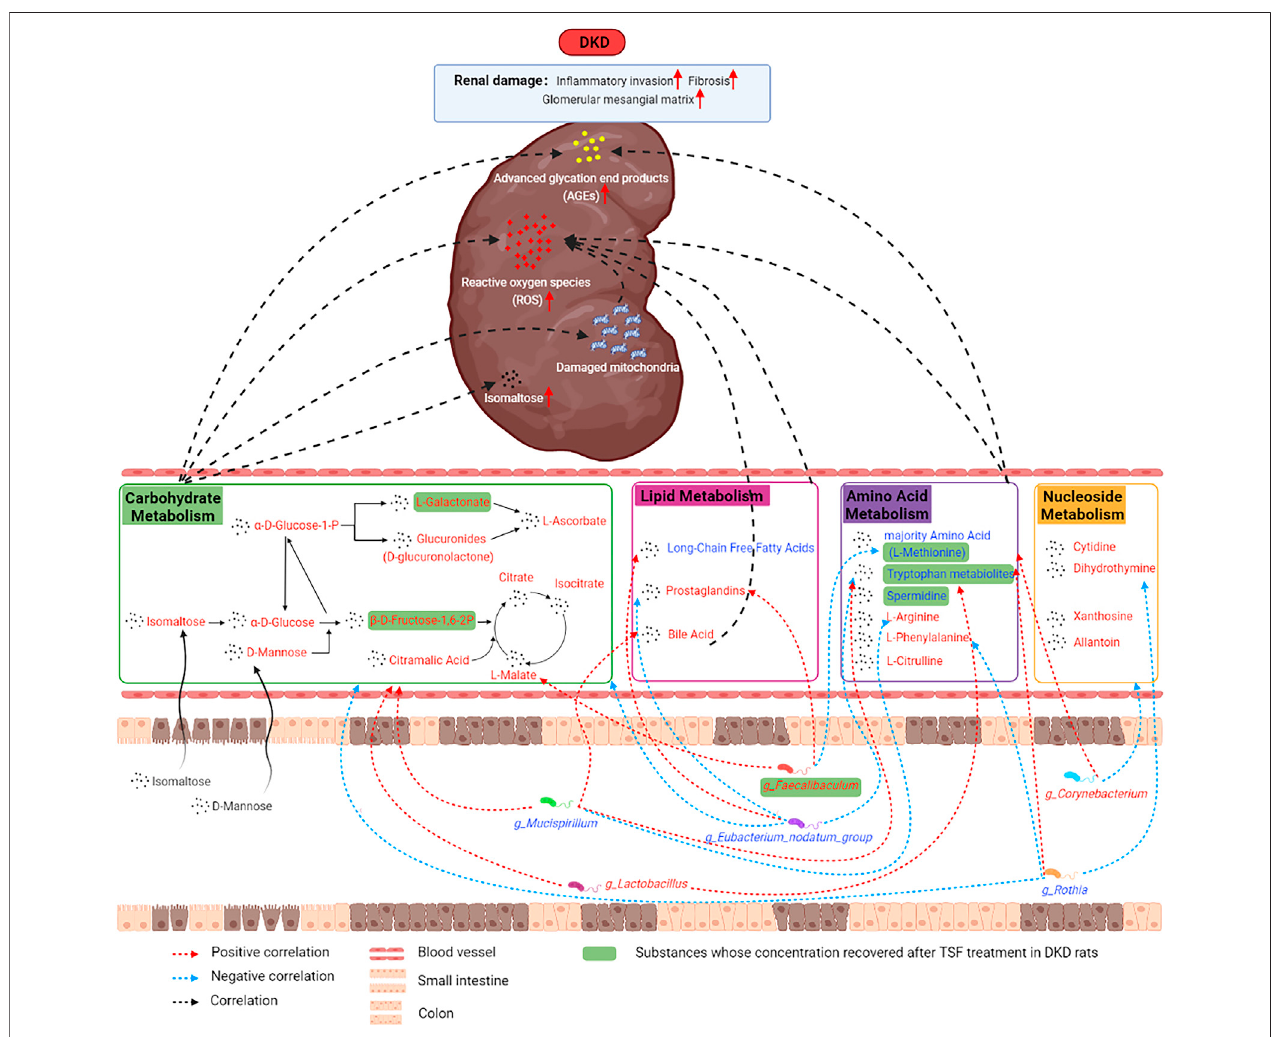
FIGURE 10 | The mechanism diagram illustrated the potential mechanisms between altered serum metabolic pro fi les, disturbances in gut microbiota, and kidney damage in DKD.